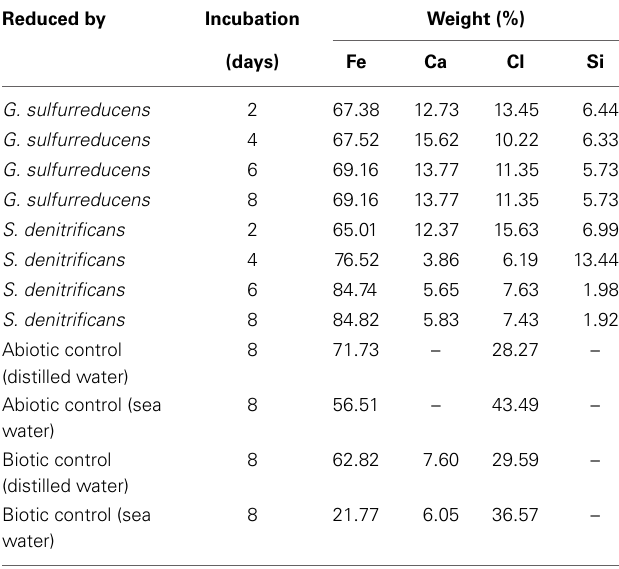
Table 4 | Results of EDX-SEM analyses for the ochre sample treated with